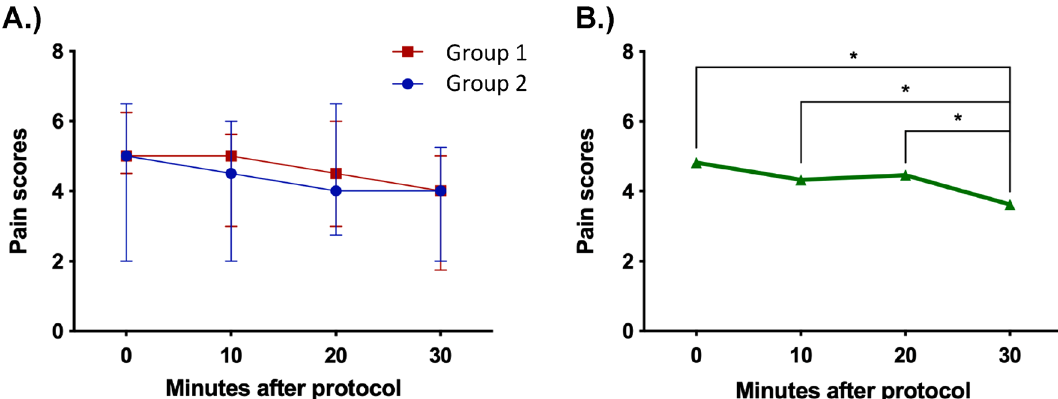
Figure 3. ( A ) Median pain scores with interquartile range for intervention group 1 (n = 18) and intervention group 2 (n = 17) (Supplementary material) ( B ) Mean pain scores for the entire sample size (n = 35) at 0, 10, 20 and 30 min. The first segment of VR was administered between 0 and 10 min and the second segment between 20 and 30 min. Intervention group 2 were administered passive then active content, whilst intervention group 1 were administered active then passive content. A two-way mixed model ANOVA with multiple comparisons and a Bonferroni correction was used to determine significance. *Denotes p < 0.05.